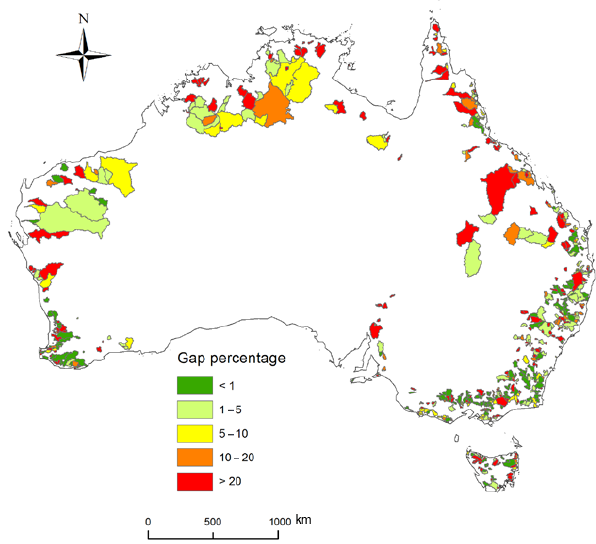
Figure 1. The 780 unregulated catchments grouped by different streamflow data gaps for the period of 1981–2010.